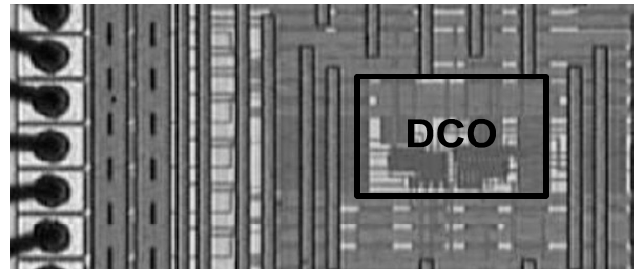
Figure 8. The chip microphotograph of the DCO chip.